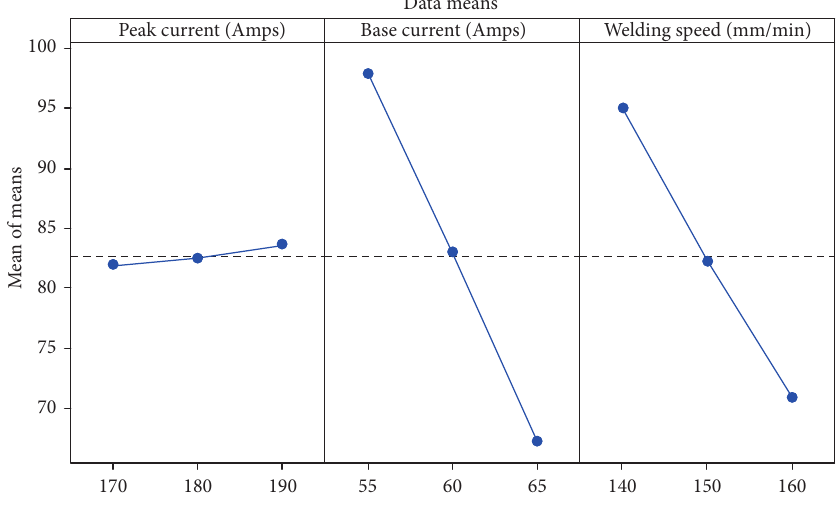
Figure 6: Main effect plot for the tensile strength